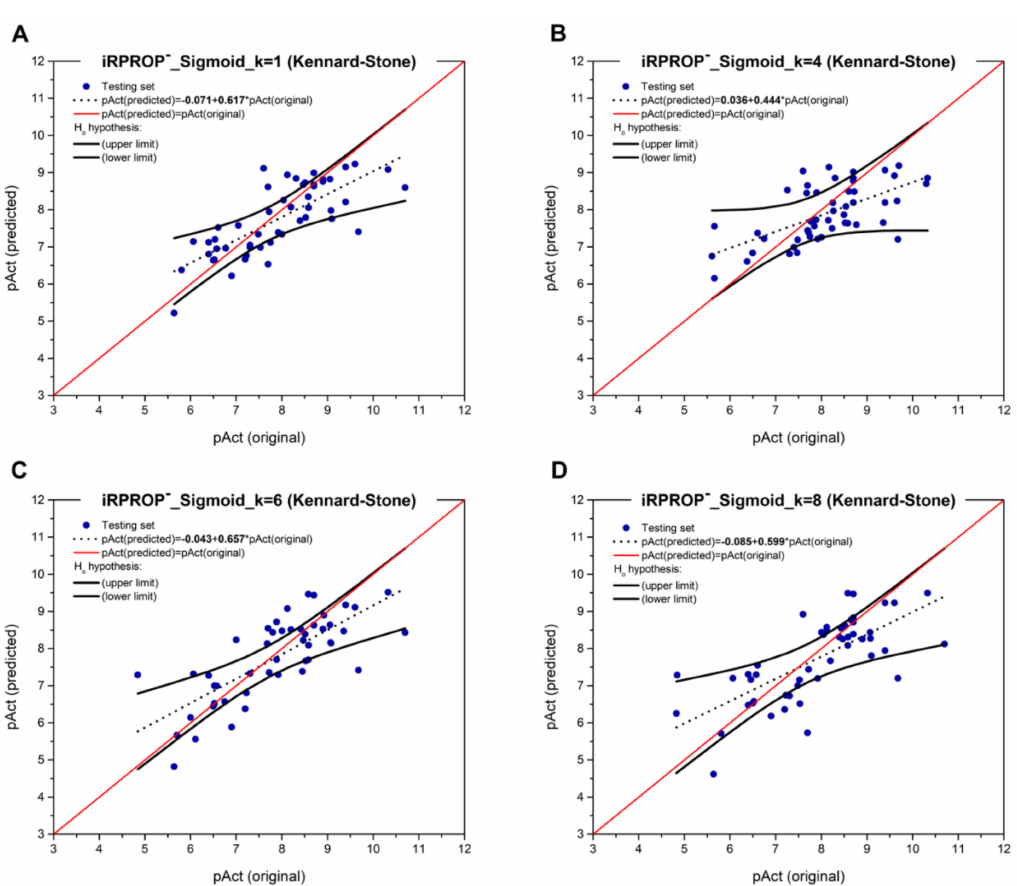
Figure 8. Linear regression parameters for the testing set, and upper and lower limit curves for statistical hypothesis H 0 verification. MLPs with one hidden layer, iRPROP − optimizer, and Sigmoid activation for ( A ) k = 1 ( D 1 ), ( B ) k = 4 ( D 4 ), ( C ) k = 6 ( D 6 ), ( D ) k = 8 ( D 8 ) VLA-based SMILES representation,